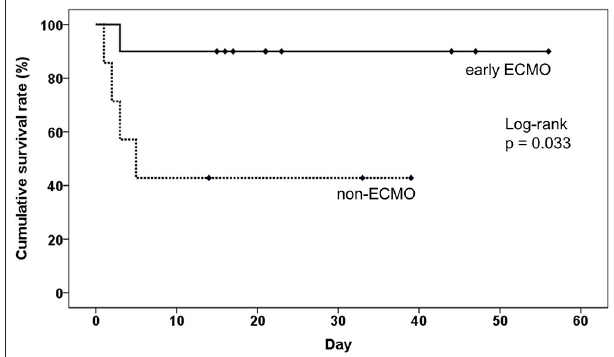
FIGURE 4 | The impact of earlier ECMO treatment on the overall survival of pulmonary embolism patients without sudden cardiac arrest. ECMO, veno-arterial extracorporeal membrane